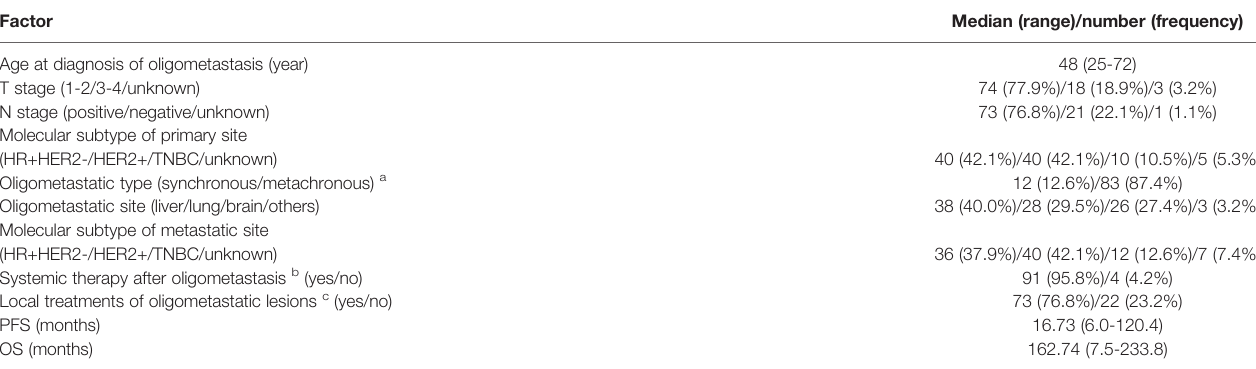
TABLE 1 | Clinicopathological characteristics of 95 female oligometastatic breast cancer patients.